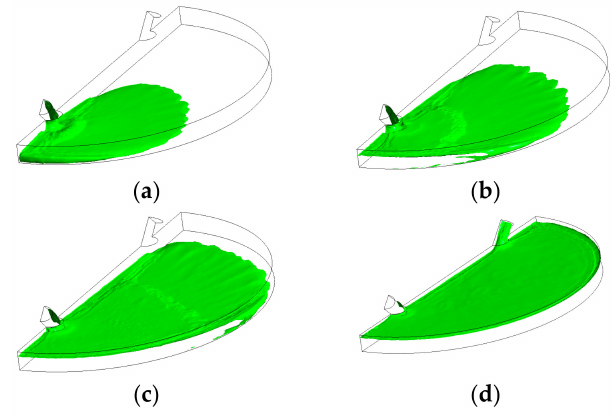
Figure 3. Free-surface during chamber flooding at the following times: ( a ) 5 s < τ c ; ( b ) 7 s < τ c ;